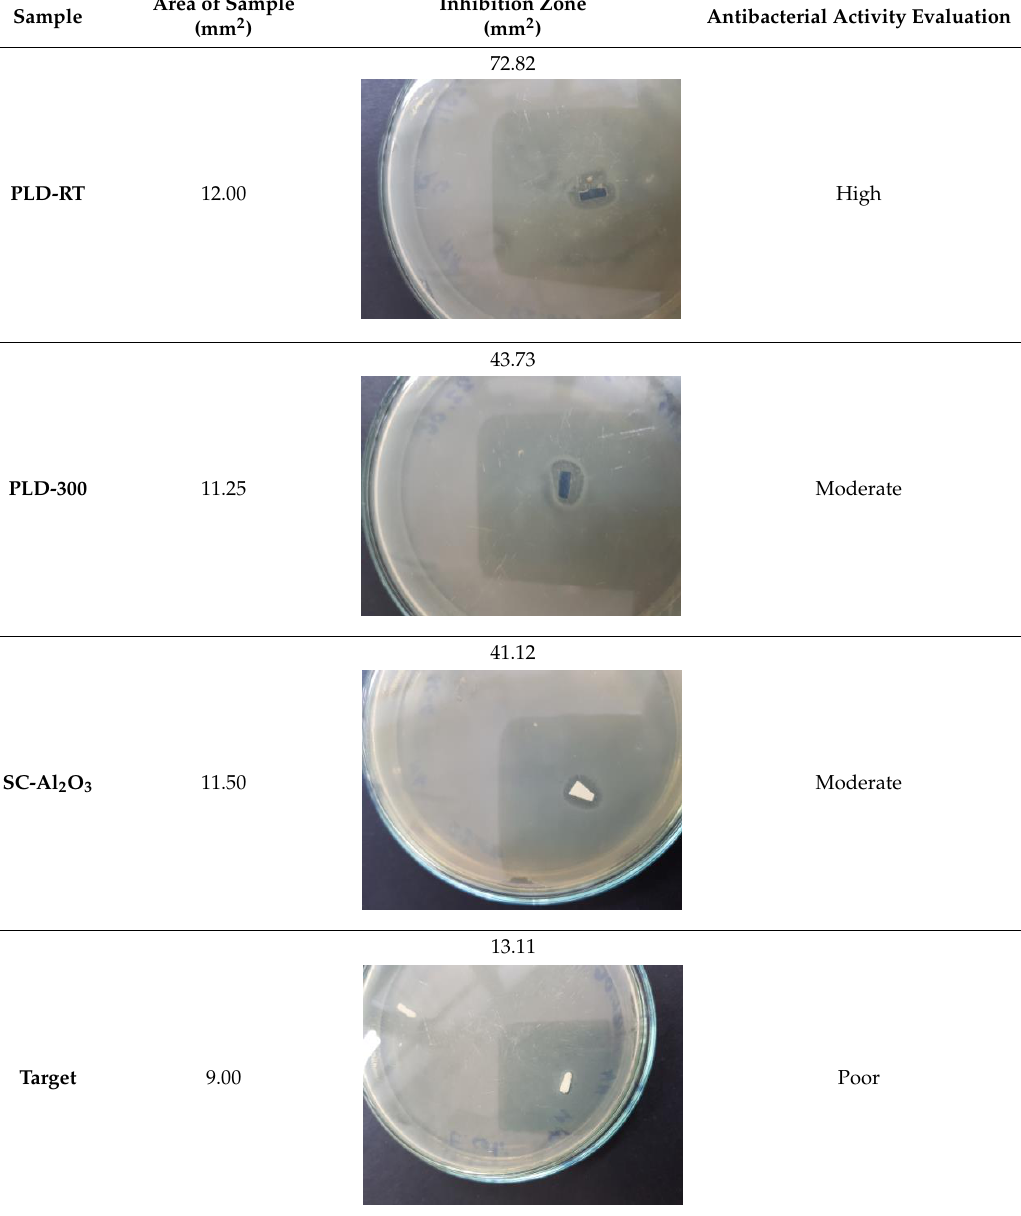
Table 4. Details of antibacterial activity evaluation.